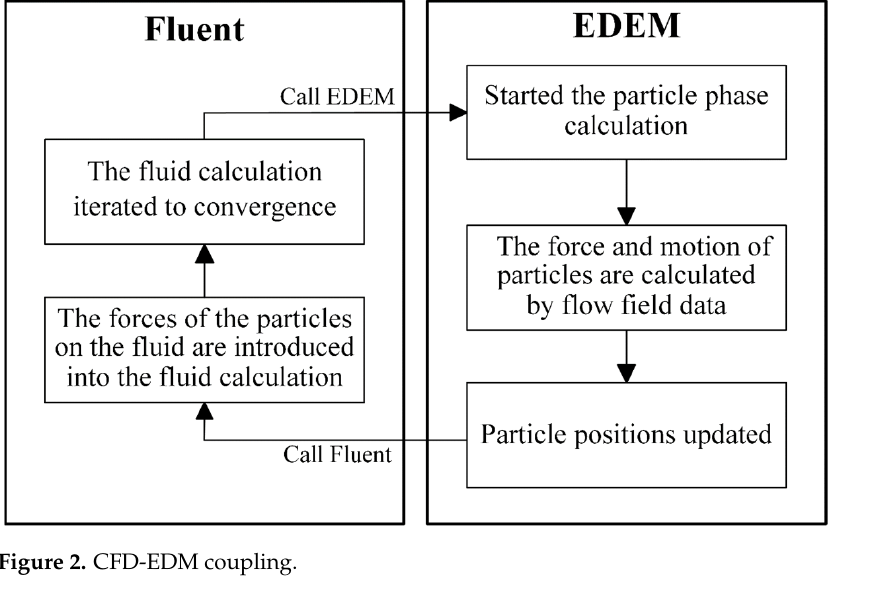
Figure 2. CFD-EDM coupling.